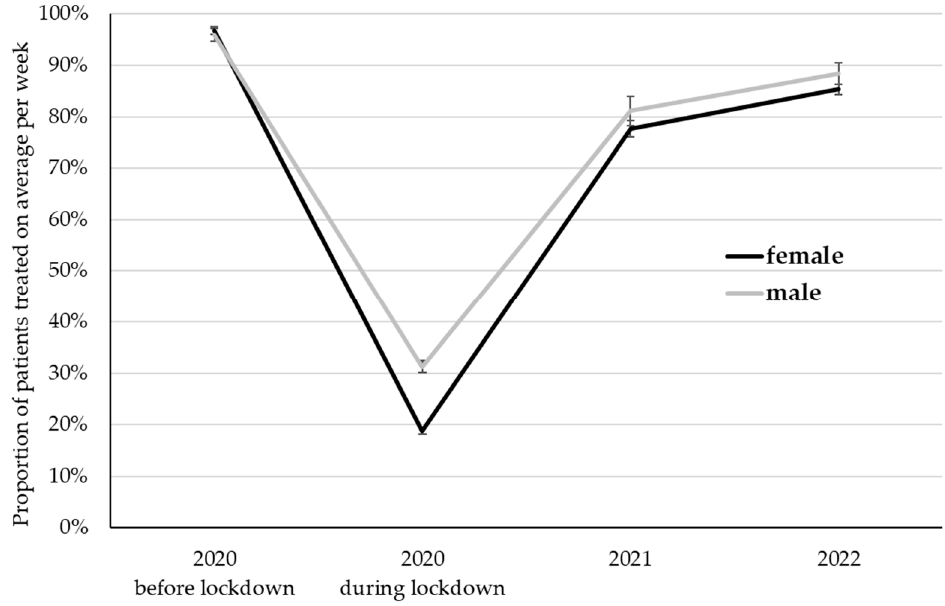
Figure 2. The proportion of patients treated on average per week in personal contact. LS Mean ± standard error.